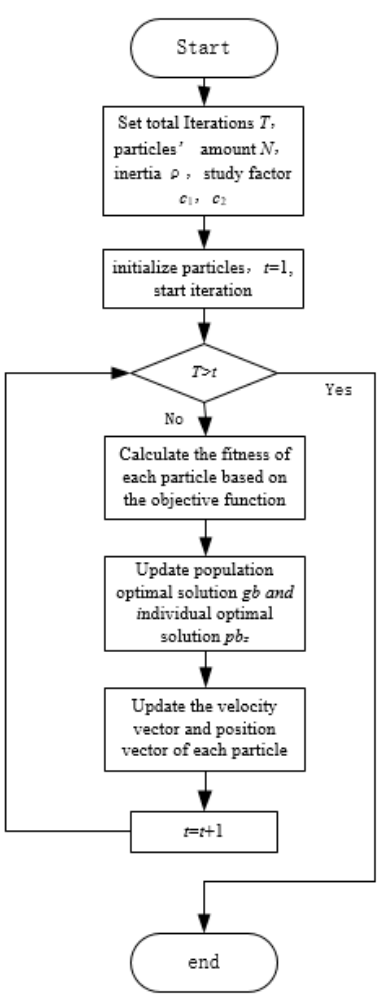
Figure 4. Flow of the particle swarm optimization (PSO) algorithm.